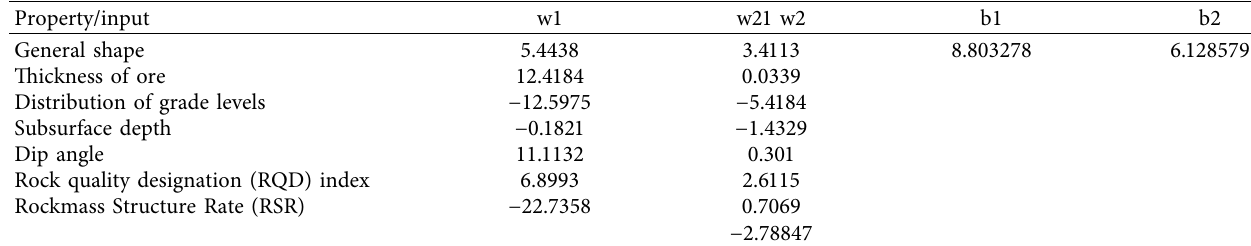
Table 6: Values for weight (W) and bias (b) derived from the MATLAB toolbox.